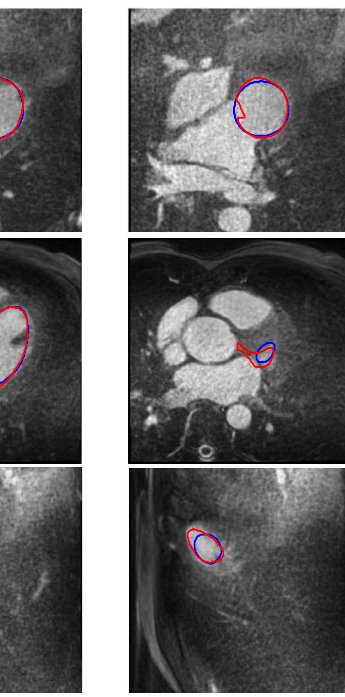
Figure 10. The ground truth (red) and the result of 3D interpolation (blue) are shown. The interpolation is obtained based on only one reference slice per orientation. Each row depicts a different orientation (axial, sagittal, and coronal). It is expected that the closer to the reference slice, the higher Dice coefficient is obtained ([2], Reproduced with